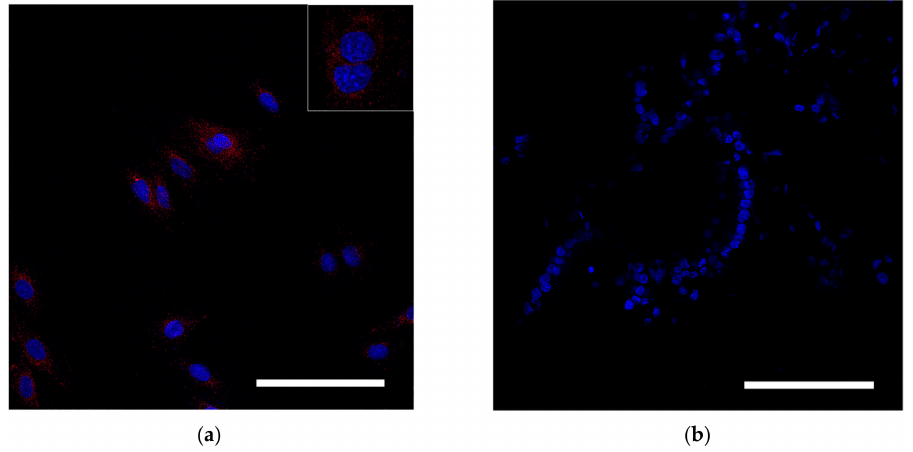
Figure 3. Assessment of SPION internalization with rabbit mesenchymal stem cells. ( a , b ) Confocal microscopy images of MSCs co-incubated with SPIONs (150 µ g/mL) for 24 h and control (non-treated cells), respectively. Nuclei were stained with DAPI (blue). SPIONs were detected by reflected laser scanning (red). Scale bars, 100 µ